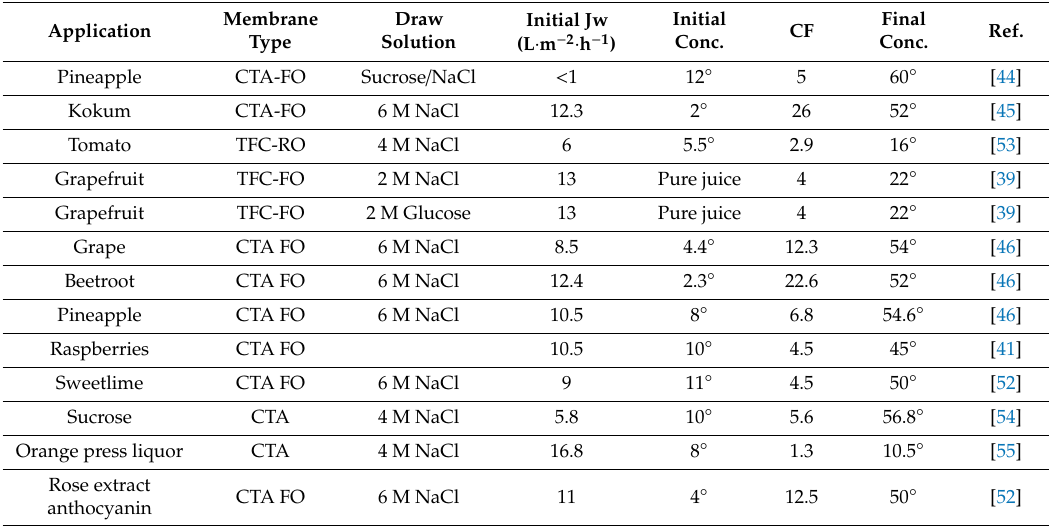
Table 2. Review of research studies of liquid food reporting concentration factor (CF) using